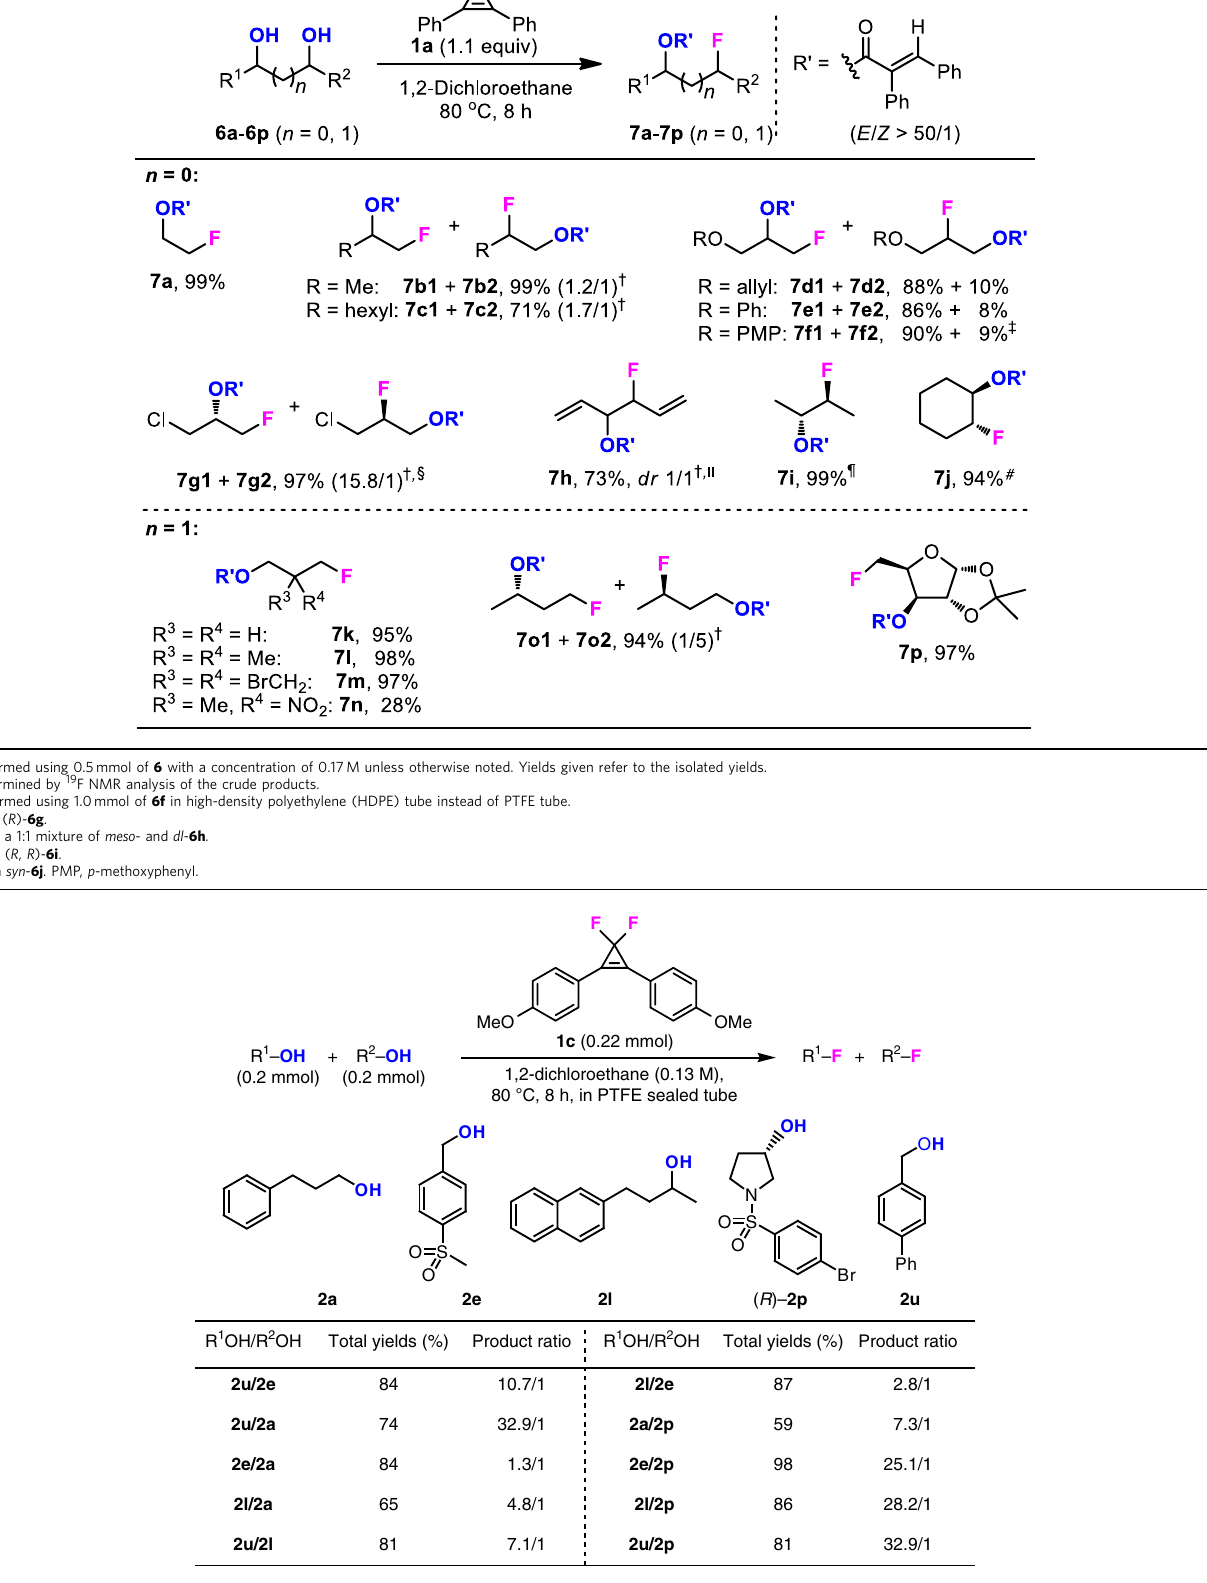
Figure 3 | Competitive deoxyfluorination of monoalcohols. Competitive deoxyfluorination of primary and secondary alcohols with CpFluor 1c . The yields and product ratios were determined by 19 F NMR spectroscopy using PhCF 3 as an internal standard.